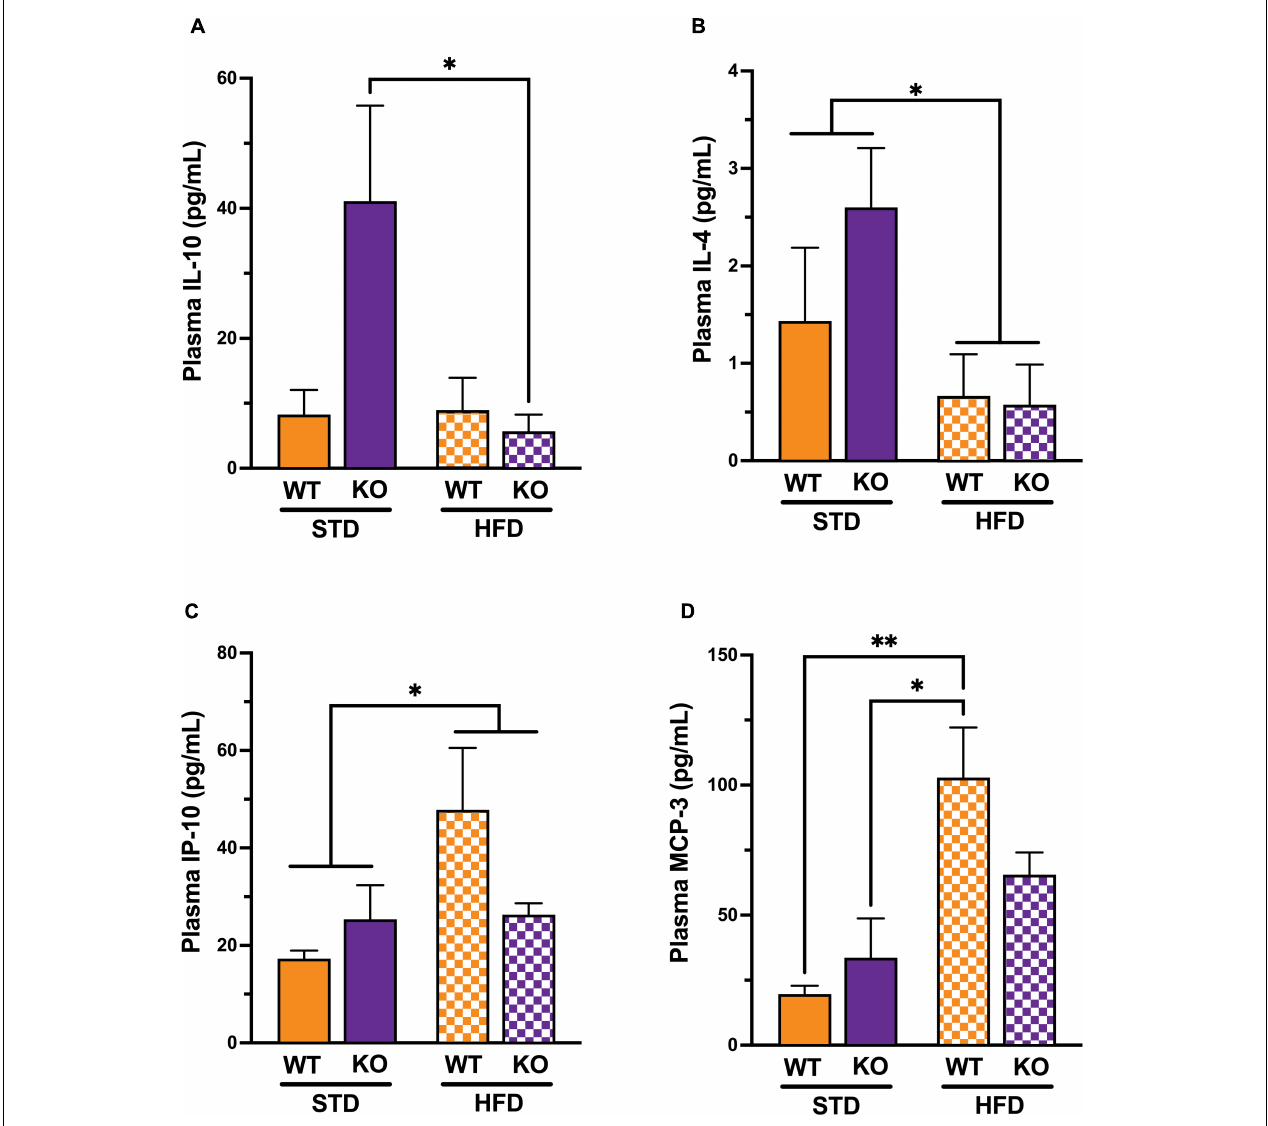
FIGURE 3 | Effects of GPR39 deficiency on systemic inflammation. (A) IL-10 showed a significant interaction between genotype and diet and a significant diet effect. The post-hoc test revealed a significant difference between KO fed with HFD and KO fed with STD, whereas no significant difference existed between WT